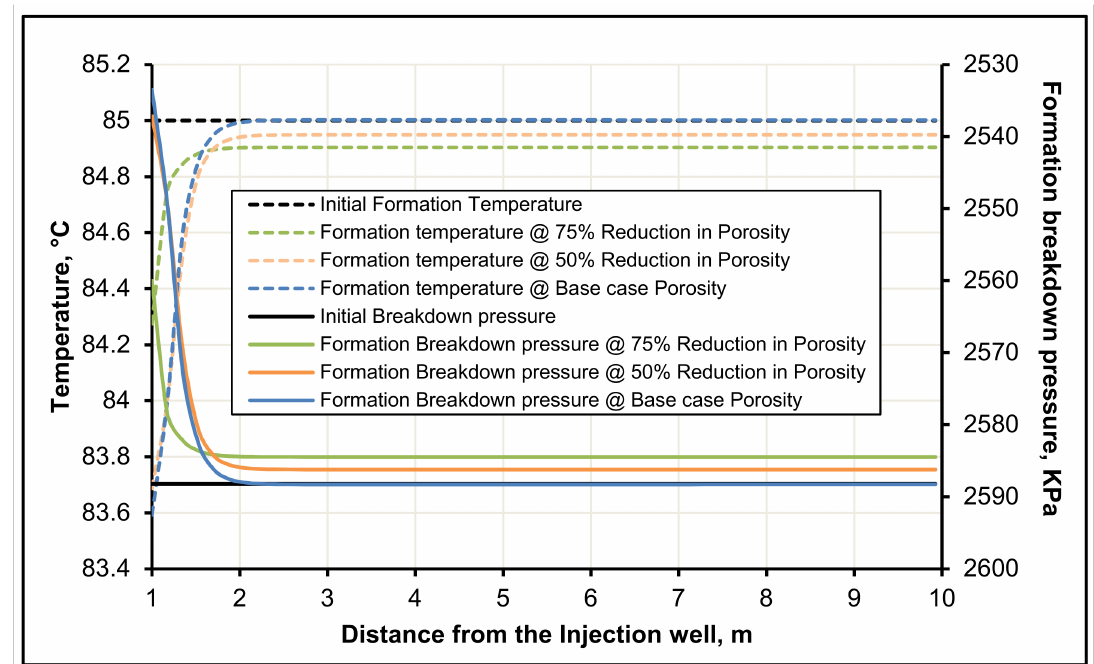
Figure 12. Formation thermal disturbance due to reduction in formation porosity with initial reservoir temperature of 85 ◦